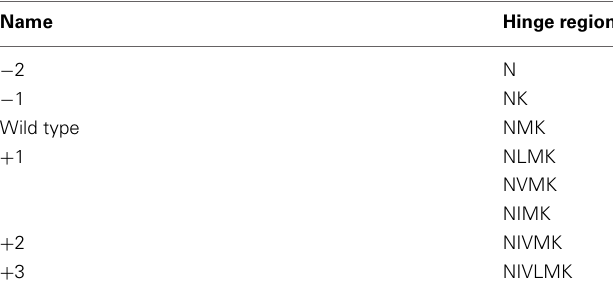
Table 2 | Sequence of the hinge region